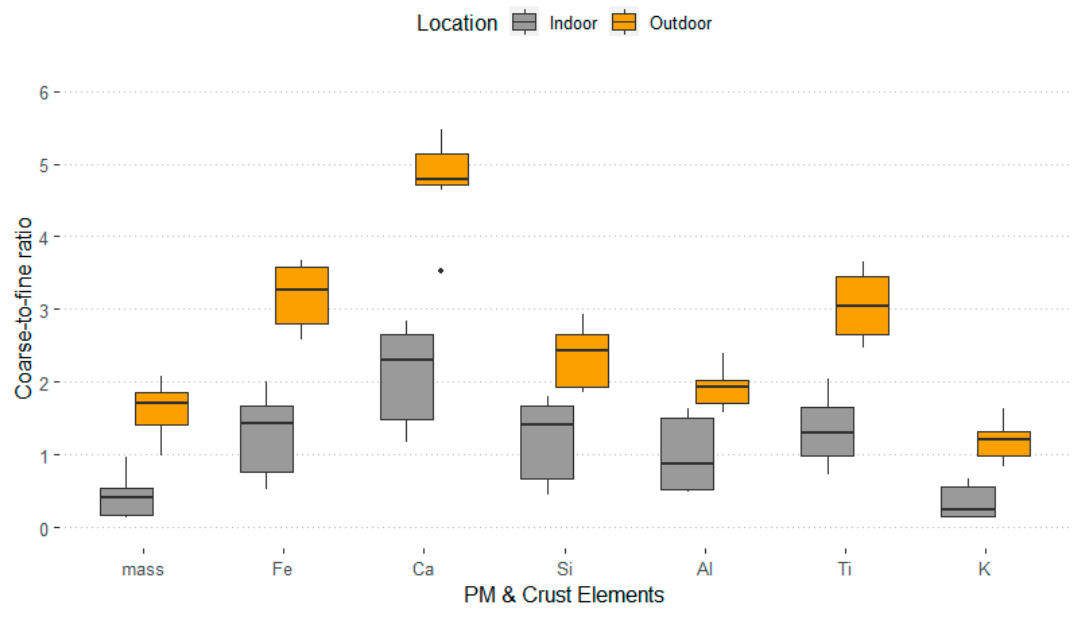
Figure 3. Coarse-to-fine particle ratios of mass and elements measured indoors and outdoors.